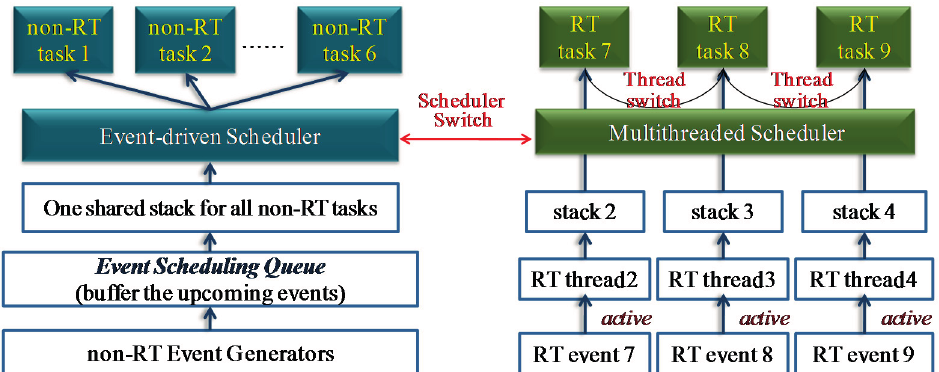
Figure 10. LiveOS hybrid scheduling mechanism. In the traditional pure